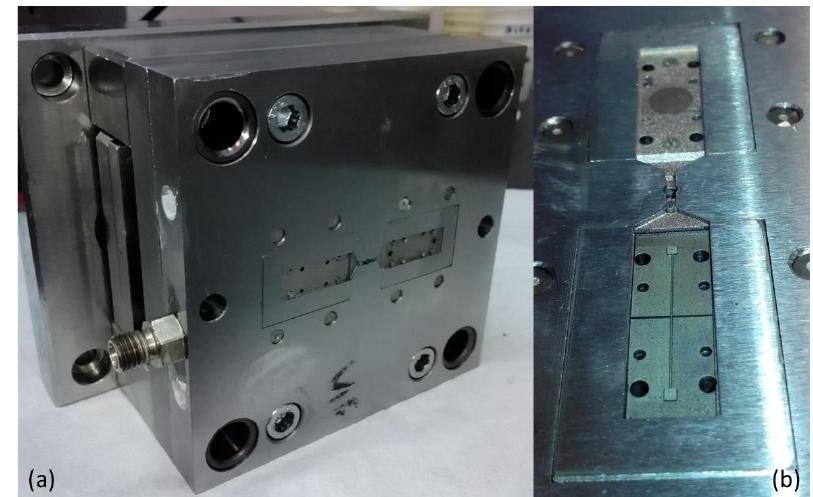
Figure 5. ( a ) Overview of the master mould and ( b ) of the inserts machined with femtosecond